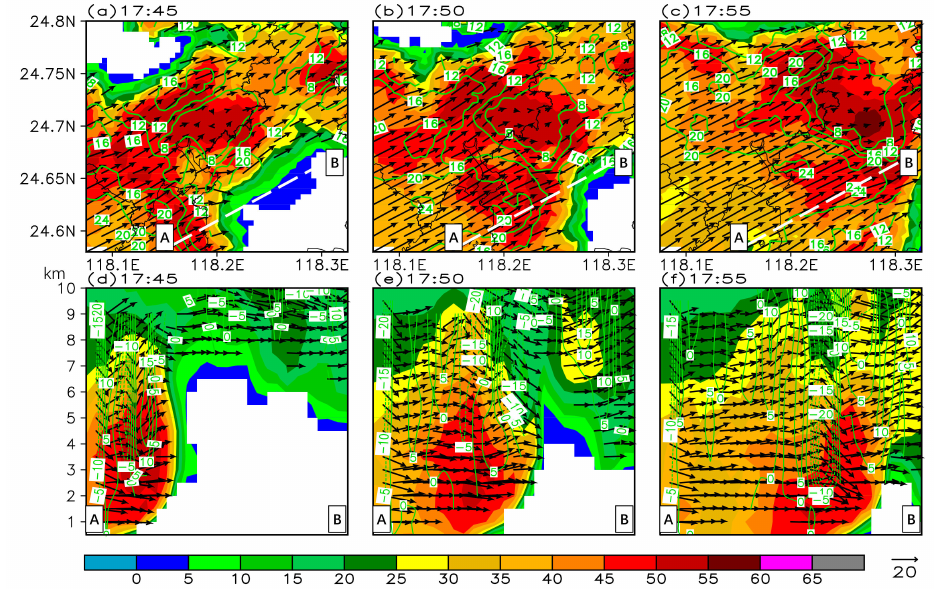
Figure 11. The retrieved horizontal wind field (black arrows; unit: m s − 1 ), reflectivity (shaded; unit: dBZ), and absolute values of horizontal velocities (green contours; units, m s − 1 ) at 3.5 km at 17:45 LST ( a ), 17:50 LST ( b ), and 17:55 LST ( c ). ( d – f ) The cross-sections of the retrieved wind field along lines A–B in ( a ) at the same times as in ( a – c ), respectively. The green contours in ( d – f ) mean the vertical component and the updraft were